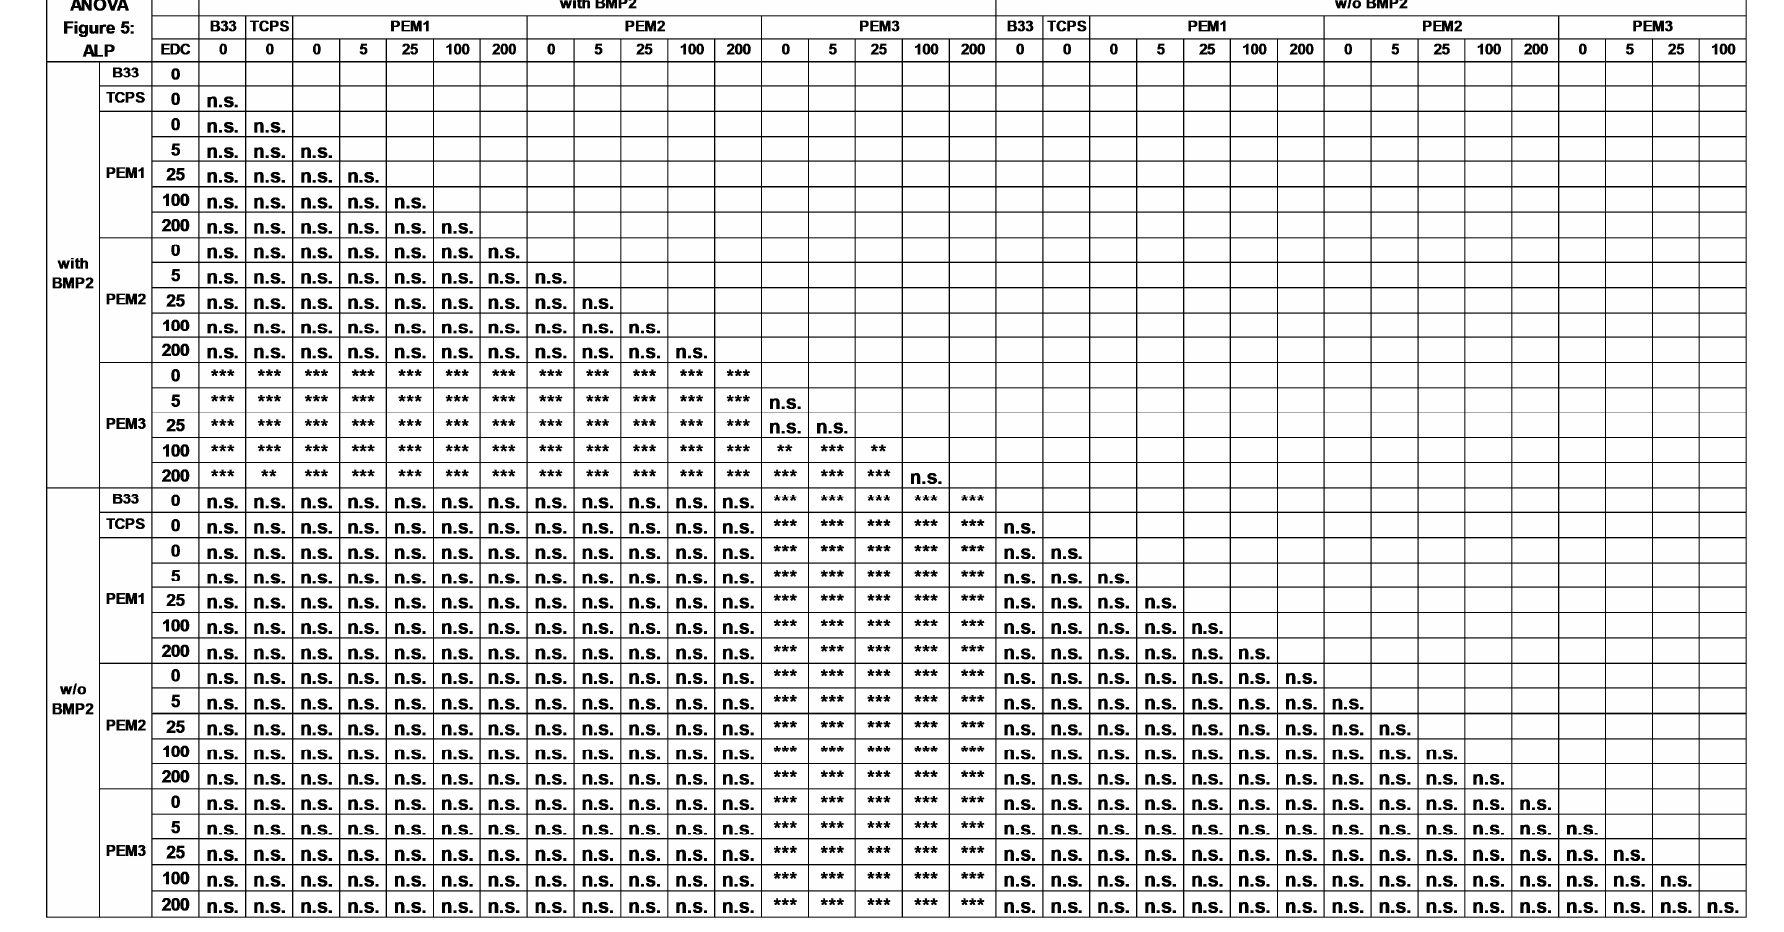
Figure A5. Results of one-way ANOVA for data related to Figure 5; n.s.: not significant; *: p < 0.1; **: p < 0.05; ***: p < 0.001.